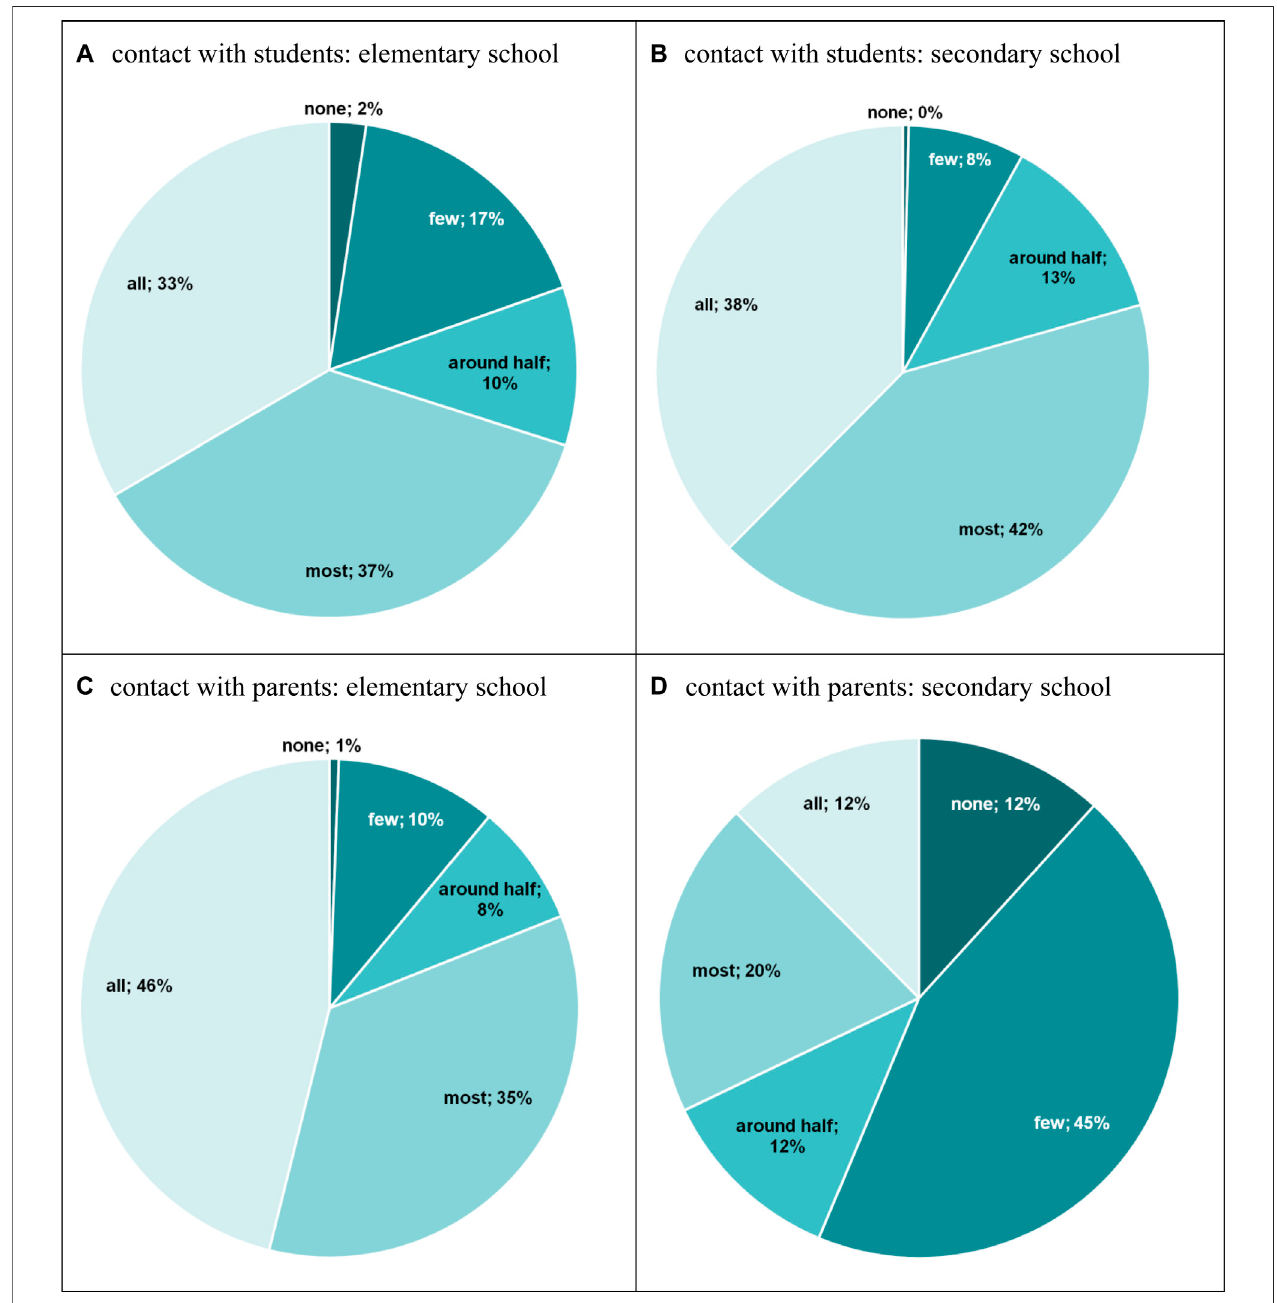
FIGURE 1 | Percentage of teachers giving the indicated responses to the question “ How many students and parents, respectively, did you stay in touch with on a regular basis during school closures? ” (A) contact with students: elementary school. (B) contact with students: secondary school. (C) contact with parents: elementary school. (D) contact with parents: secondary